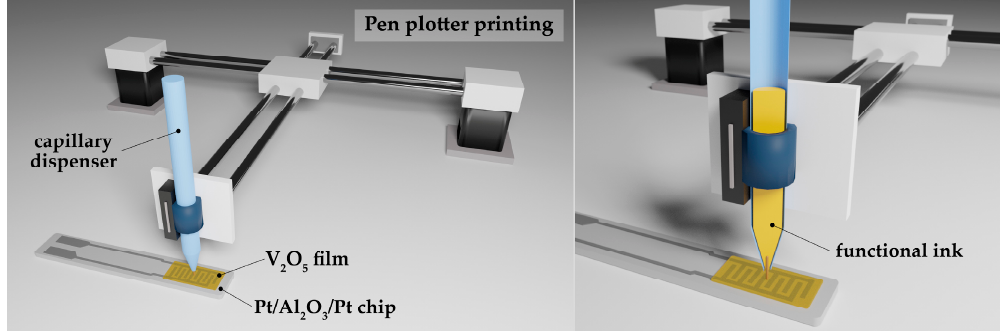
Figure 1. Scheme of V 2 O 5 thin film pen plotter printing process.